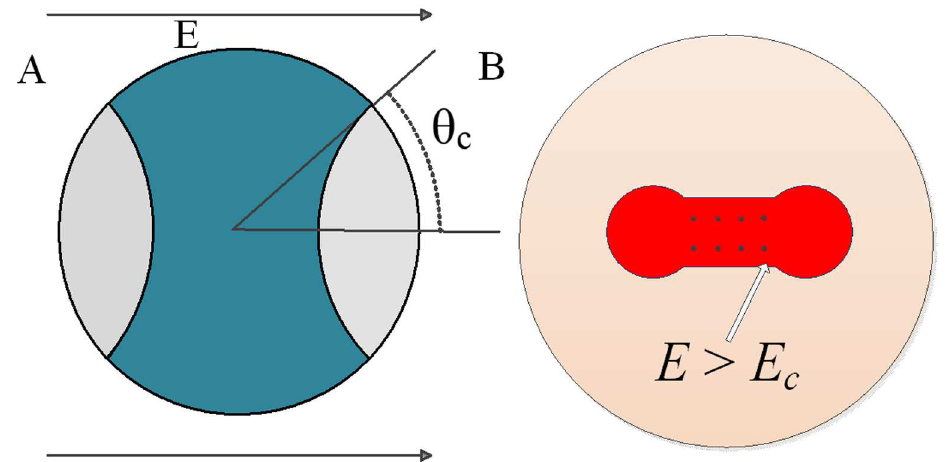
Fig 10. A: Model of a sphericalelectroporated cell exposedto an externalelectric field E . B: Model of potato tissue exposedto an externalelectric field E ; the red section represents the electroporated area, where E > E c when HVPs are